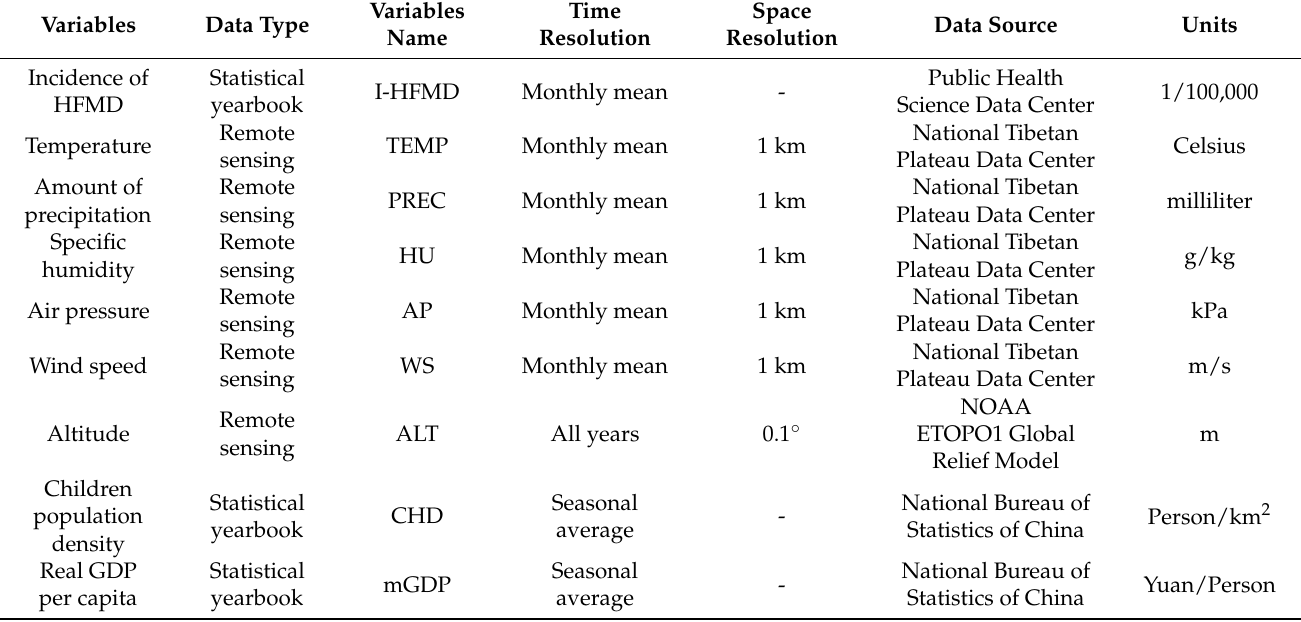
Table 1. Sources and details of potential risk factors and I-HFMD